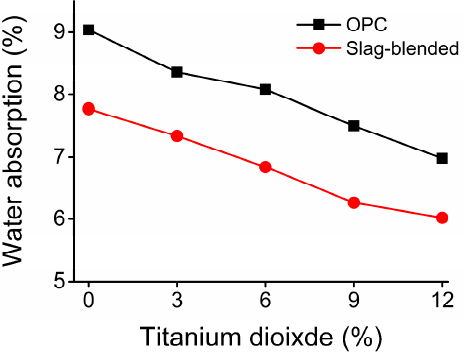
Figure 4. Variation of water absorption with the addition of nan-TiO 2 in the mortars.